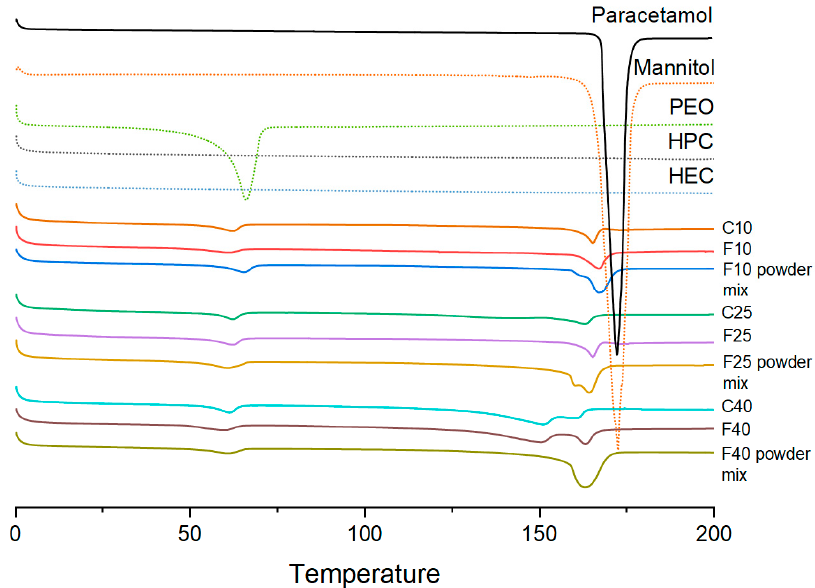
Figure 6. DSC analysis of individual polymers, the powder mixtures, extruded filaments (F10, F25, F40), and printed cores (endothermic events plotted downwards).